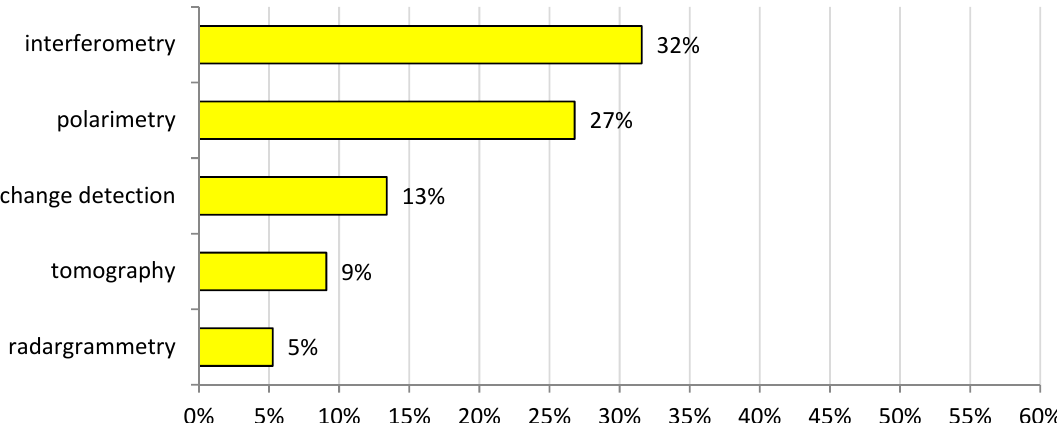
Figure 9. Thematic fields of methodological and technical research related TerraSAR-X proposals, sorted by frequency addressing differential SAR interferometry including its further developments such as PSInSAR, polarimetry, automated detection of changes, SAR tomography, and radargrammetry for 3d mapping.